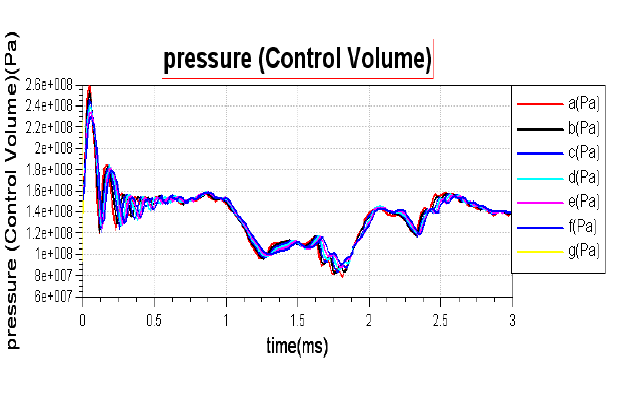
Fig.6 the influence to the pressure fluctuations